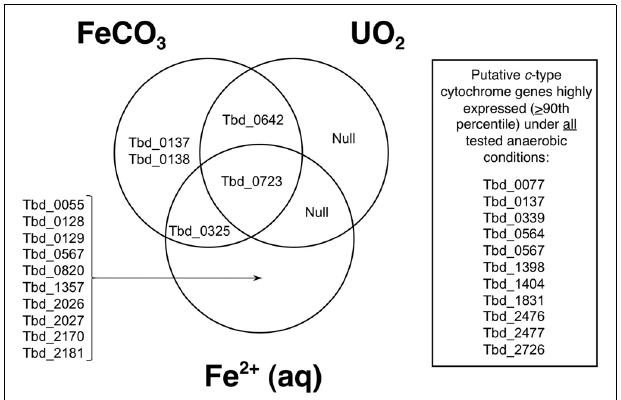
FIGURE 3 |Venn diagram showing genes from Figure 2 (mostly c -type cytochromes) that are at least twofold upregulated relative to control conditions (thiosulfate and H 2 ; GroupVII) at P ≤ 0.0001. All exposure conditions shown include H 2 , and consist of GroupV (FeCO 3 and H 2 ), GroupVI (UO 2 and H 2 ), and Group II [Fe 2 + (aq) and H 2 ]. Also shown are genes from Figure 2 that are highly expressed under all anaerobic conditions tested (see text).